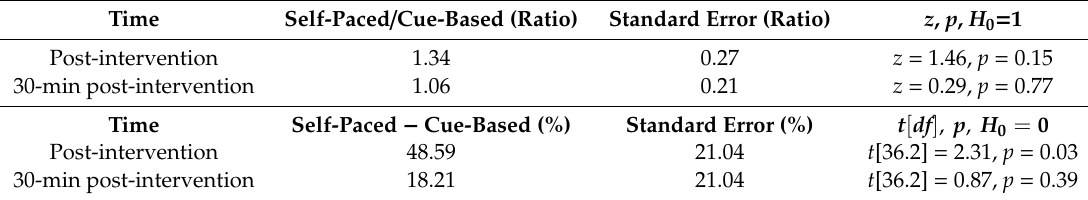
Table 2. The contrasts and standard errors are presented based on the statistical models. H 0 = 1 and H 0 = 0 stand for the null hypotheses; i.e., that contrasts of the e ff ect sizes are 1 and 0, respectively. On the ratio scale, 1 implies that the two e ff ect sizes are equal, whereas on the linear scale, 0 implies equal e ff ect sizes.